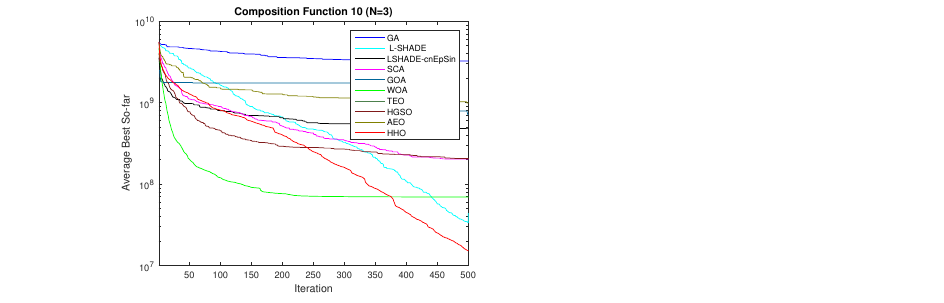
Figure 8. Convergence curve for HHO against other competitors from F21—F30 CEC2017.